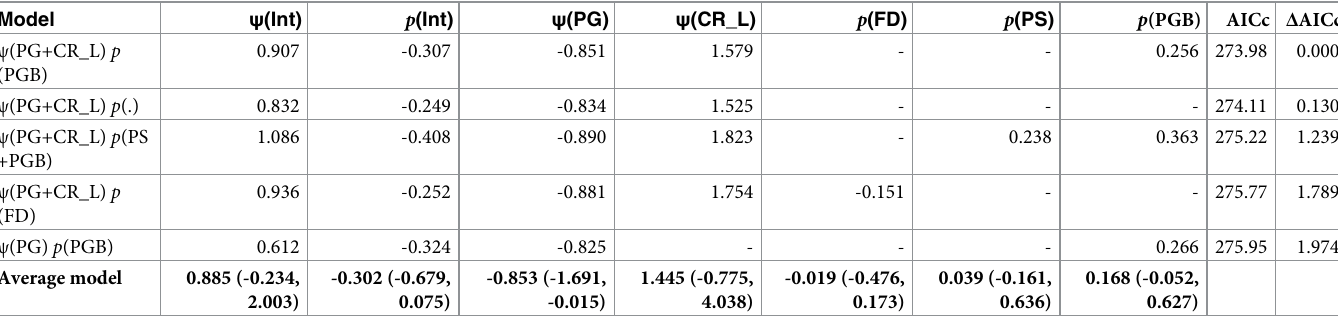
Table 2. List of the top-five single-species single-season occupancy models fit for wild boar Sus scrofa in rangelands of central Argentina and the average model.